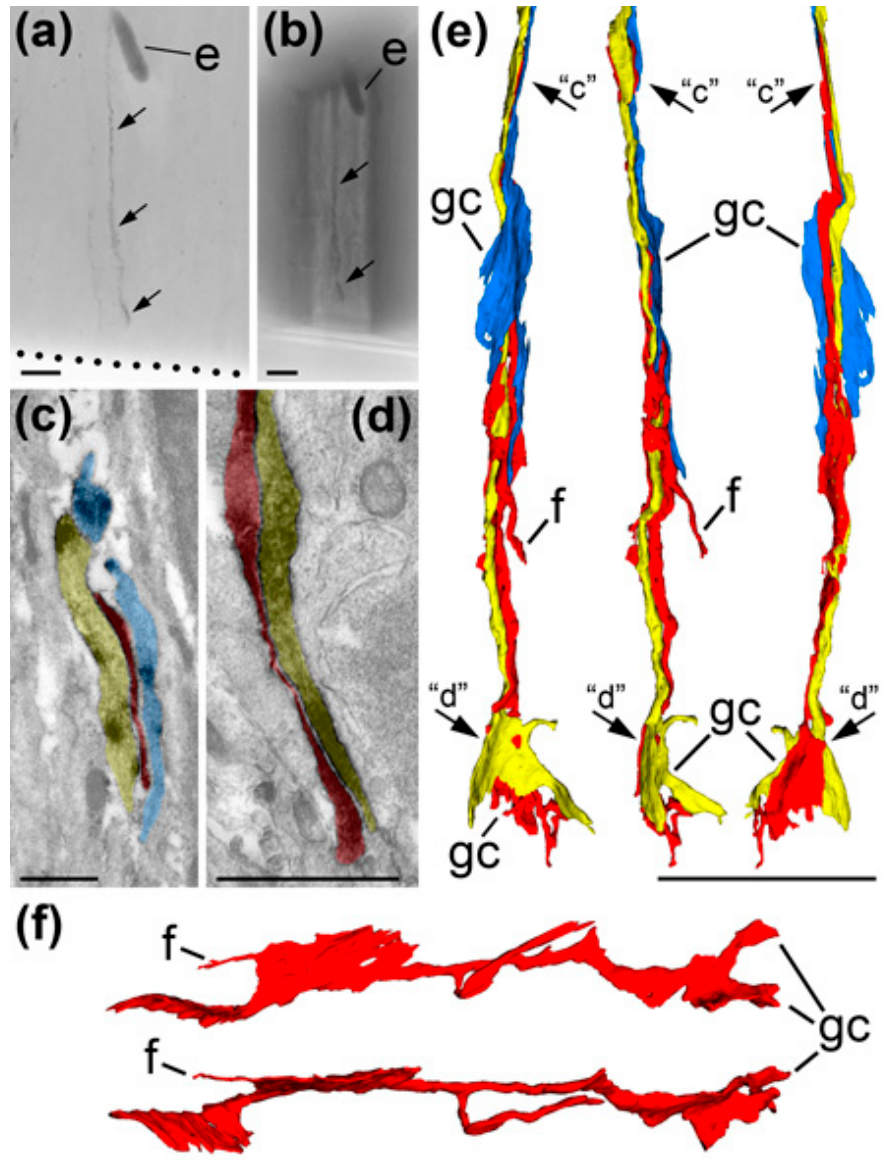
Figure 6. Correlative light-electron microscopic analysis and 3D reconstruction identify CB 1 R-positive radial processes in the cortical VZ of E45 monkey embryo as growing axons directed towards the ventricular surface and ending with growth cones (gcs). ( a ) Light microscopic image (repeated from Figure 5f) of a vertical CB 1 R-positive process (arrows) in VZ. Ventricular surface is indicated with the dotted line. ( b ) Same tissue segment trimmed for serial ultrathin sectioning. Notice trapezoid edges of the sample and the CB 1 R-positive process (arrows). Systematic analysis of serial electron microscopic images (exemplified in ( c , d )) resulting in 3D reconstruction ( e ) of the CB 1 R-positive processes identifies that it represents three axons (correspondingly depicted semitransparent red, yellow and blue in electron micrographs and same colors in 3D reconstruction) tightly following each other. Three 3D images in ( e ) are reciprocally rotated 90 degrees. Arrows “c” and “d” indicate approximate positions of the CB 1 R-positive axon segments shown in ( c , d ), respectively. ( f ) Another example of the CB 1 R-positive growth cone in VZ. Two 3D images are reciprocally rotated 90 degrees and placed with growth cone directed right while in the tissue it was directed towards ventricular surface. Notice that all growth cones (gcs) are flattened and end with sharp tips. While vast majority of CB 1 R-positive axons at this developmental stage are growing horizontally through IZ (see Figure 5), vertical orientation of these axons and position of the growth cones close to ventricular surface identify those misorientation. Abbreviation: e, erythrocyte in blood capillary; f, filopodium. Scale bars: ( a , b , e , f ) 10 μ m and ( c , d ) 1 μ m.